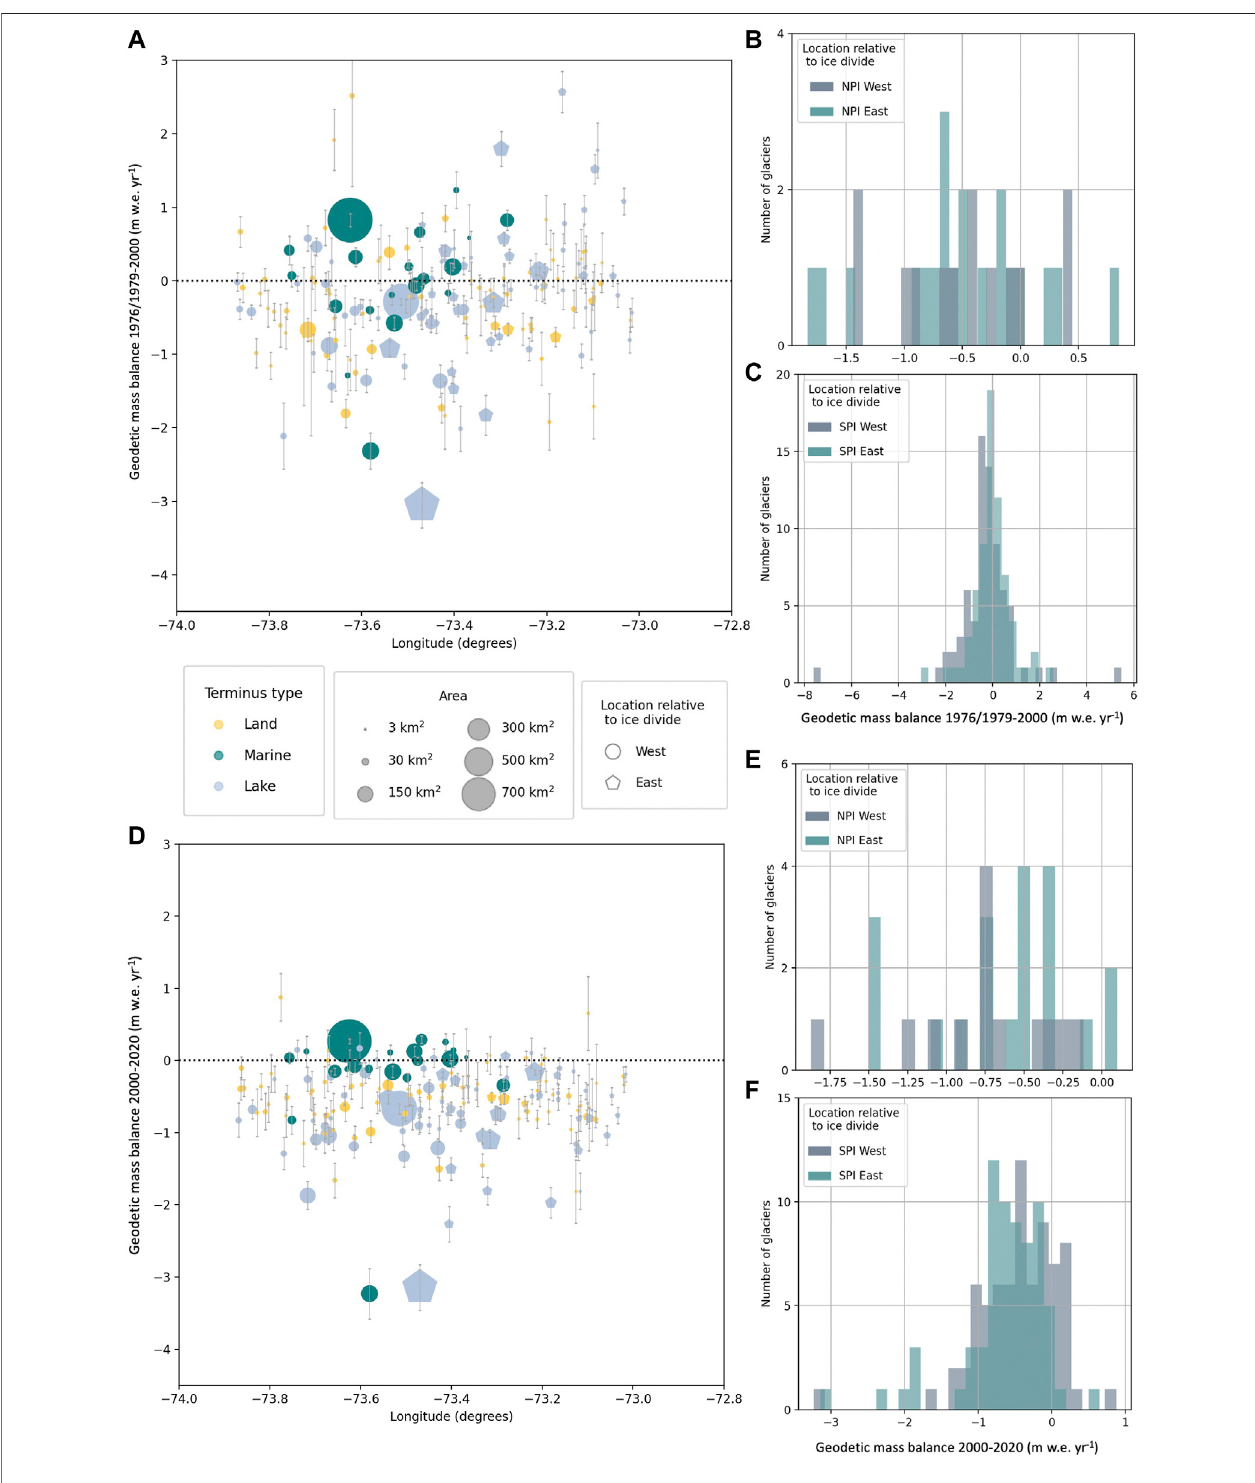
FIGURE 7 | Geodetic massbalance plotted with longitude for (A) the historical time period (1976 – 2000overlap and 1976/1979 – 2000 overlap in Table 3 ), clipped to − 4 to +3 m w.e. yr − 1 to show the spread around 0 m w.e. yr − 1 ; and (D) the modern time period (2000 – 2020 overlap in Table 3 ). Histograms for 1976/ 1979 – 2000 (B,C) and 2000 – 2020 (E,F) show the distribution of geodetic mass balance according to glacier location east or west of the ice divide.